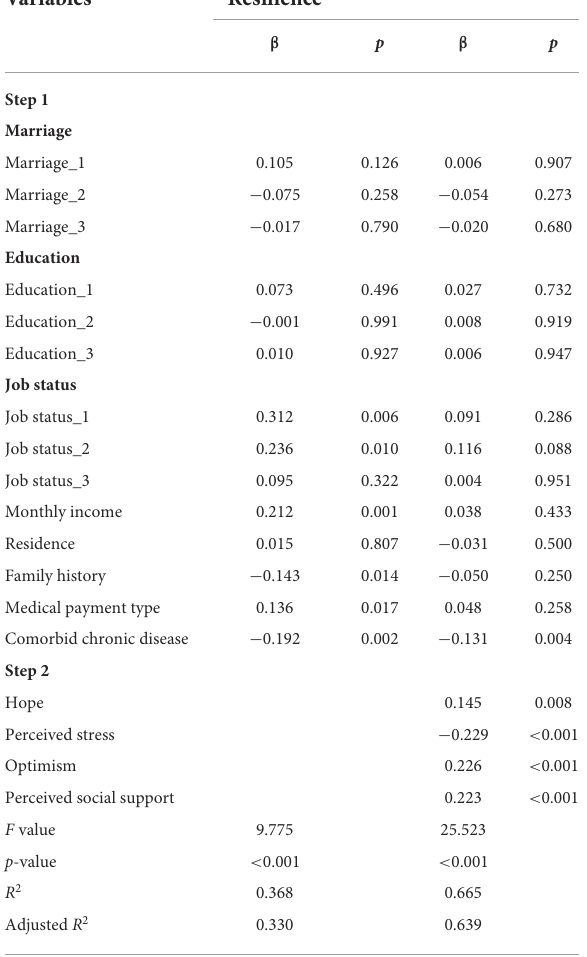
TABLE 3 Hierarchical linear regression analysis on results of resilience ( n = 250).